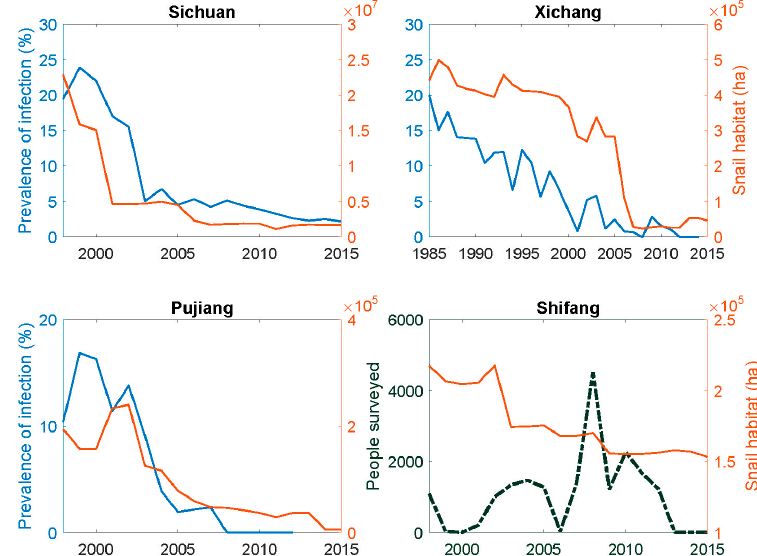
Figure 2. Historical trends of schistosomiasis prevalence of infection and intermediate snail host habitat for Sichuan Province (1998–2015), Xichang (1985–2015), Pujiang (1998–2015), and Shifang (1998–2015) counties. For Shifang county, the dotted line shows number of people surveyed each year, as only 40 people (out of 1088) were found infected in 1998.